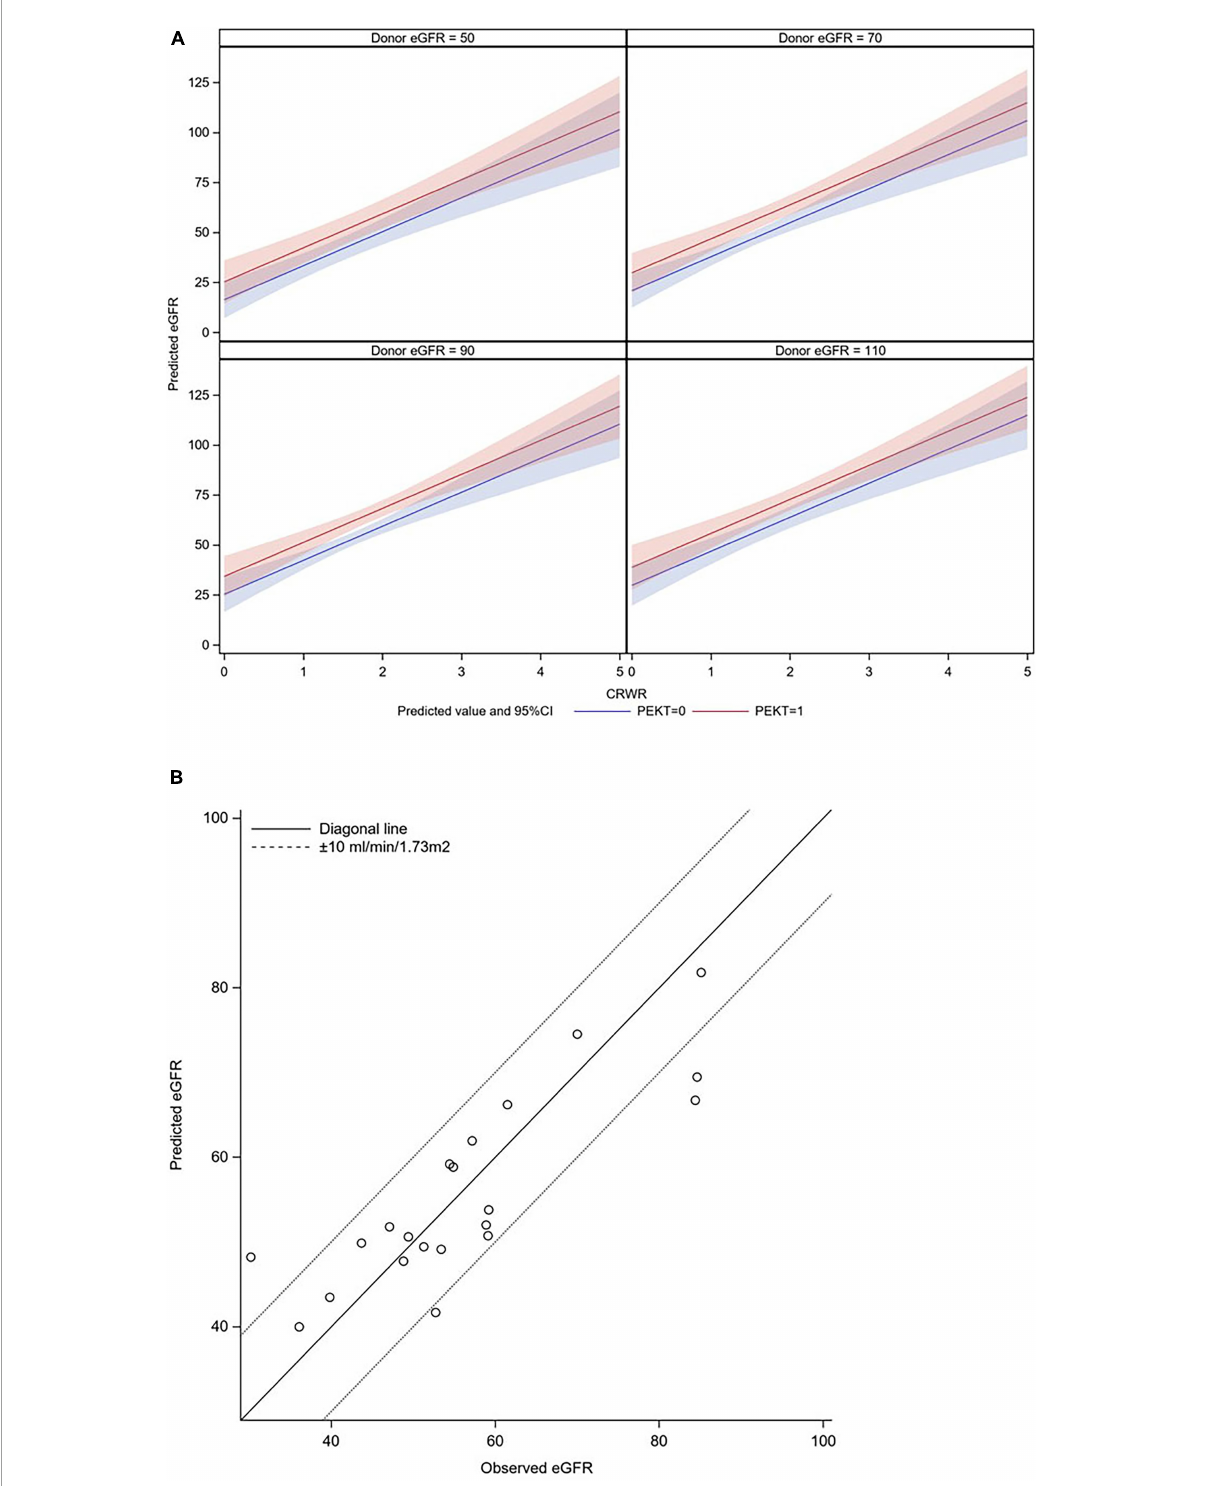
FIGURE4 Graphic illustration of the formula for predicting eGFR at 1-month posttransplantation and its validation. (A) Graphic illustration of the formula. The donor eGFR is divided into approximately 50, 70, 90, and 110 ml/min/1.73 m 2 . It was possible to calculate the postoperative eGFR for each CRWR according to the presence or absence of PEKT (red line; with PEKT, blue line; without PEKT). (B) Validation. In most patients (17/21), the observed eGFR was within a 10 ml/min/1.73 m 2 margin of the predicted